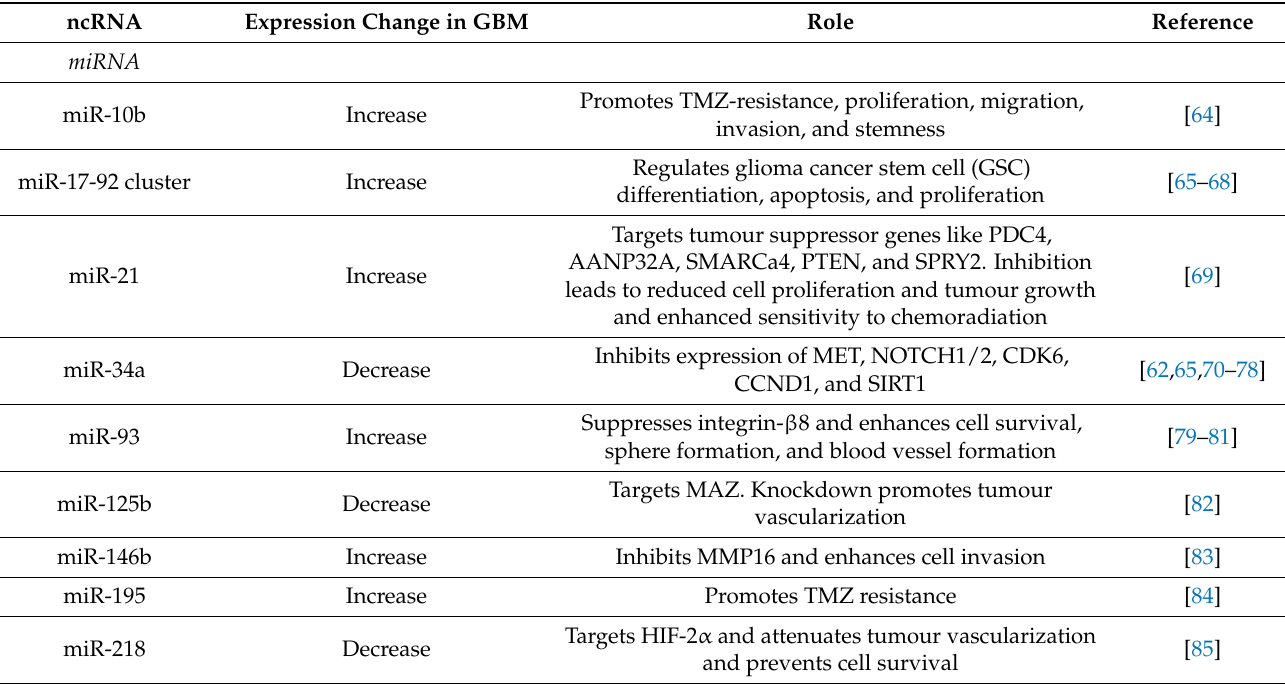
Table 1. Key functional miRNAs and lncRNAs in glioblastoma